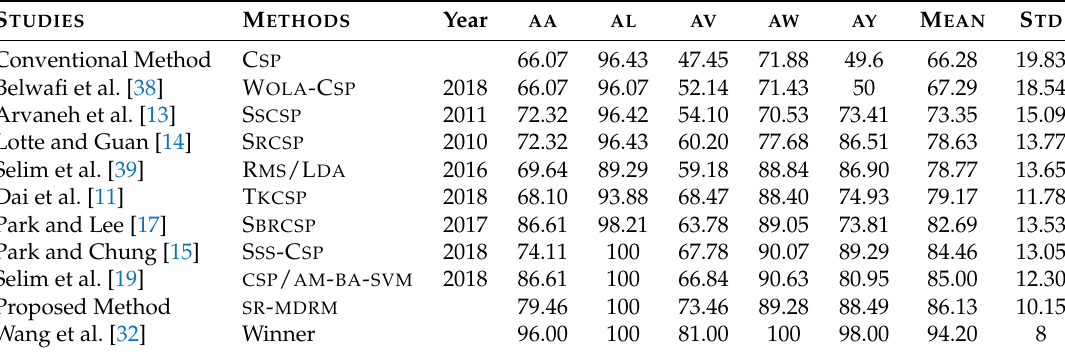
Table 3. Classification accuracy (Mean and Standard deviation in percent) of the proposed approach and other MI classification approaches on Dataset IVa, BCI Competition